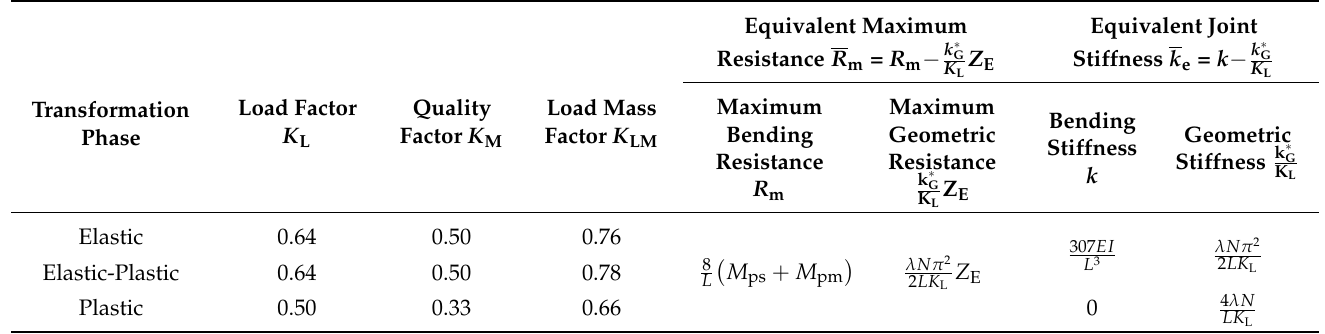
Table 1. Model characteristics